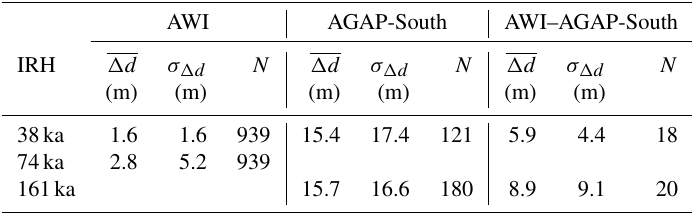
Table 3. Mean values of absolute depth differences (cid:49)d , standard deviations σ (cid:49)d and number of crossovers N from the crossover analysis for the different IRHs and RES data